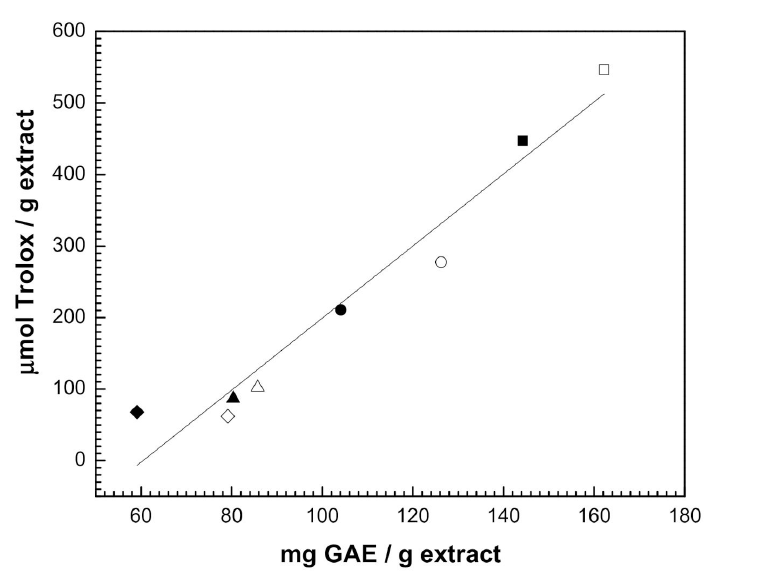
Figure 2. Correlation between antioxidant activity ( µ mol Trolox / g) and total phenolic compounds (mg GAE / g) of licorice UAE extracts (Table 3). T = 25 ◦ C: ( (cid:4) ) ethanol, ( • ) methanol, ( (cid:78) ) ethanol:water and ( (cid:95) ) methanol:water. T = 50 ◦ C: ( (cid:3) ) ethanol, ( ) methanol, ( ∆ ) ethanol:water and ( ♦ ) (cid:35)